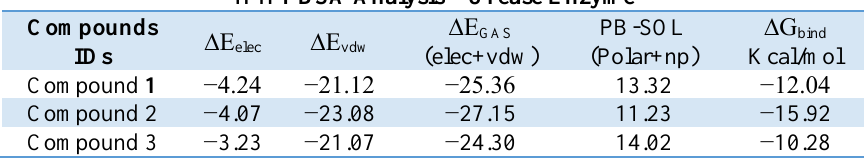
Figure 4. RMSD (all the atoms) ( A ) and per residue RMSF plot ( B ) of urease enzyme (PDB ID: 4GOA) in free and bound form with respect to initial minimized structures. Protein ligand complexes are color coded as Compound 1 (blue), Compound 2 (red), Compound 3 (green), Free protein (purple). ( C ) Major residues contributing towards protein ligand interactions. (All values are given in Kcal/mol) ( D ) Free energy of binding ∆ G bind for all compounds ( 1 , 2 and 3 ) using MMPBSA approach.